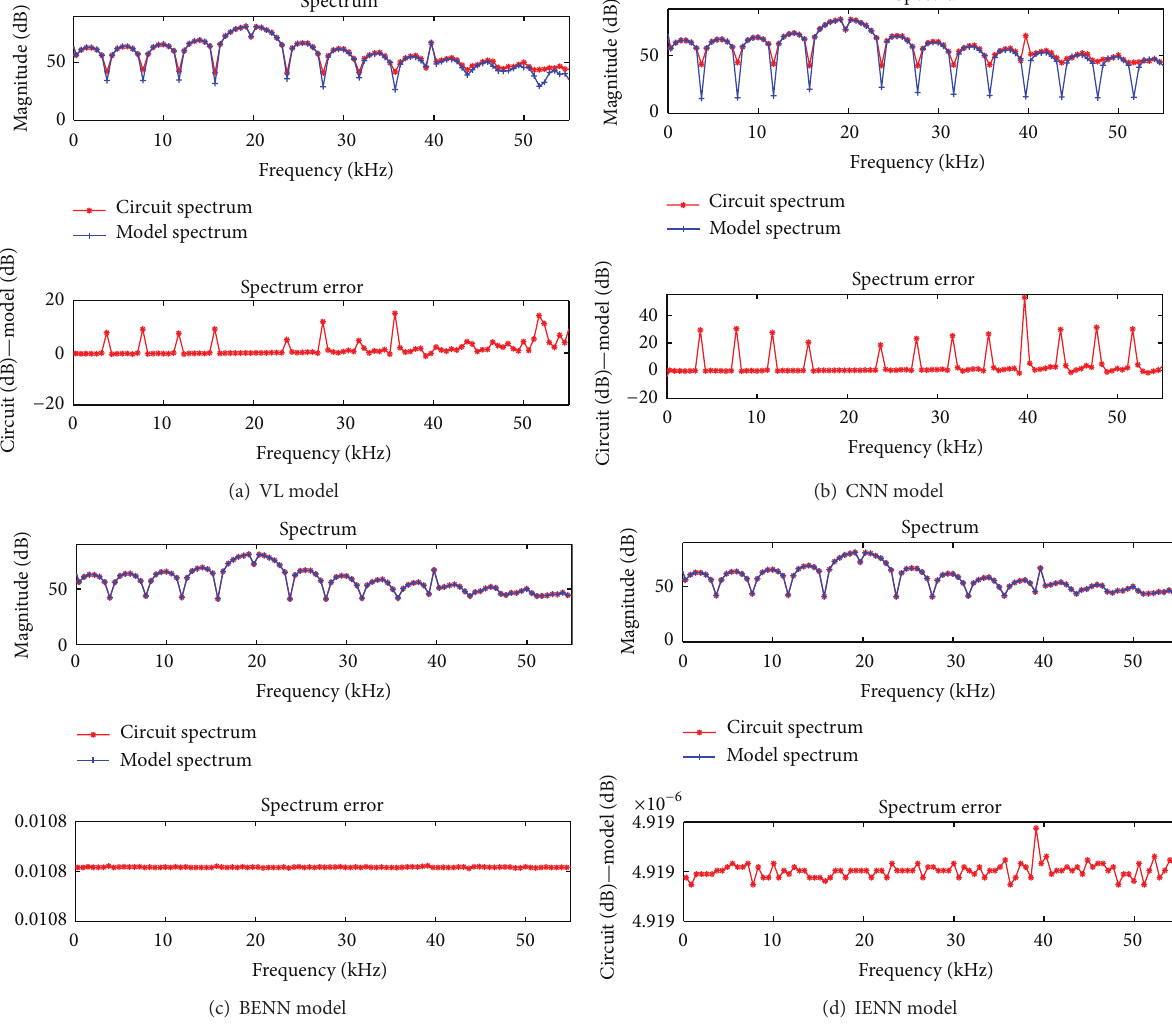
Figure 10: Comparison among four behavioral models in frequency domain with 2PSK signal input.